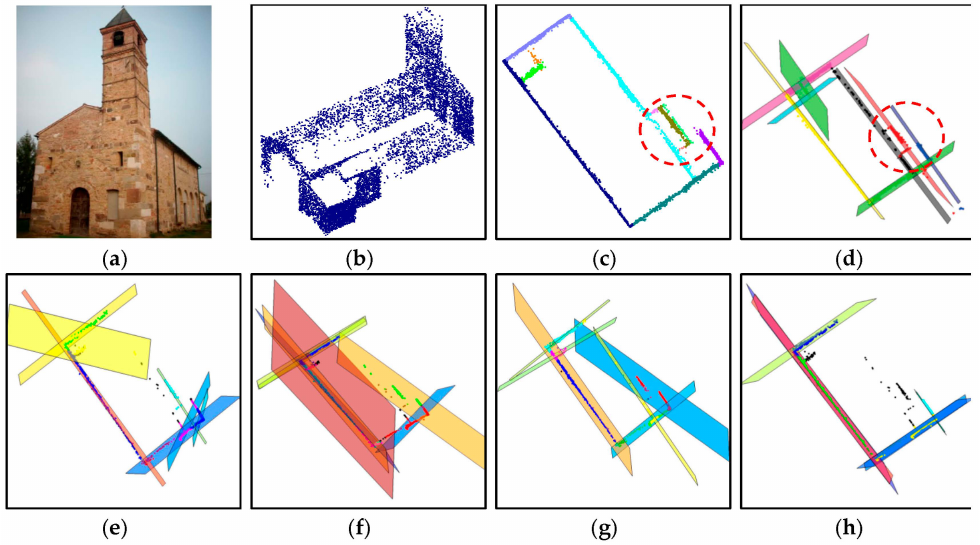
Figure 20. Result comparison using Pozzoveggiani dataset: ( a ) image of Pozzoveggiani church; ( b ) 3D points of Pozzoveggiani church; ( c ) top view of the result from the proposed approach; ( d ) result from J-linkage; ( e ) result from Residual Histogram Analysis (RHA); ( f ) result from MultiRANSAC; ( g ) result from sequential RANdom SAmple Consensus (RANSAC); and ( h ) result from mean-shift.